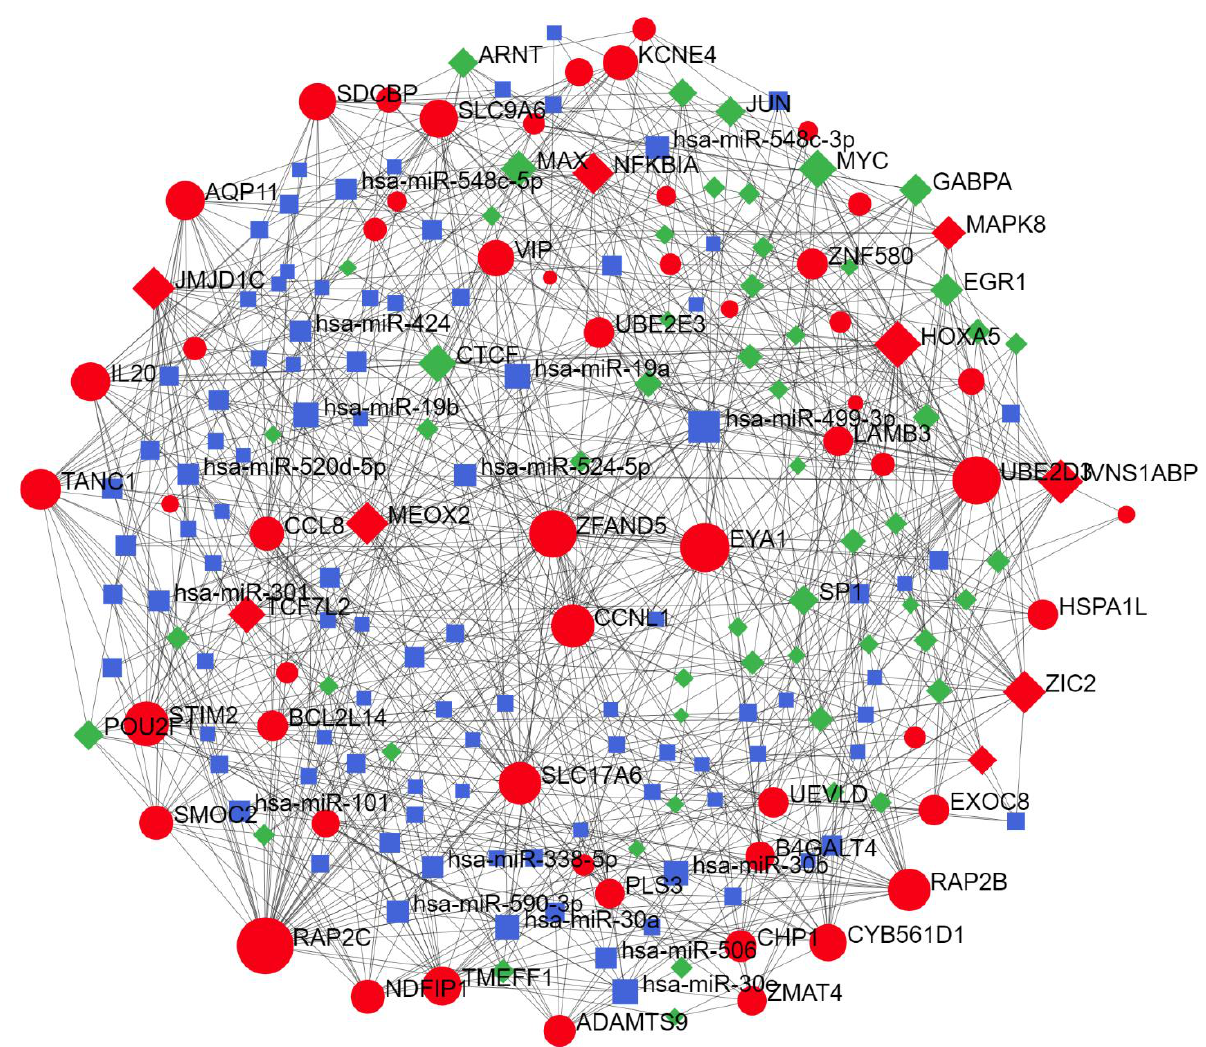
Figure 3. miR-TF regulatory network related to miR-499 functional modules in thyroid tissue. ZIC2 , NFKBIA , RAP2C , HOXA5 , and TCF7L2 were identified as the main driver nodes. Red nodes indicate seed nodes used for network reconstruction (see Supplementary file 1 for the statistical network details), green nodes indicate TFs, and blue nodes indicate miRs. miR, microRNA; TF, transcription factor; ZIC2, zic family member 2; NFKBIA, nuclear factor-kappa B inhibitor alpha; RAP2C, member of RAS oncogene family; HOXA5, homeobox A5; TCF7L2, transcription factor 7 like 2. Table 4. Top enriched pathways related to tissue-specific functional sub-networks of miR-499. Each section depicts the top 10 pathways for each network. The upper section shows pathways enriched by the tissue-specific PPIN, mostly involved in antigen recognition and signaling cascade. The middle section displays pathways enriched by the tissue-specific gene co-expression network, of which the main driver nodes are involved in Rho GTPase signaling, cytokine signaling, and adaptive immune system regulation. The bottom section lists the pathways enriched by miR-TF in thyroid tissue, indicating its role in immune system signaling (mainly via toll-like receptors) cascades and inflammation induction. Pathway Enriched by Tissue-Specific Protein–Protein Interaction Network Pathway Total Expected Hits p -Value FDR * Antigen processing: ubiquitination and proteasome degradation